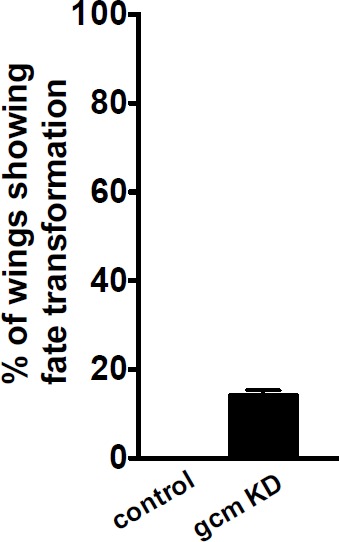
DOI:
http://dx.doi.org/10.7554/eLife.15983.032